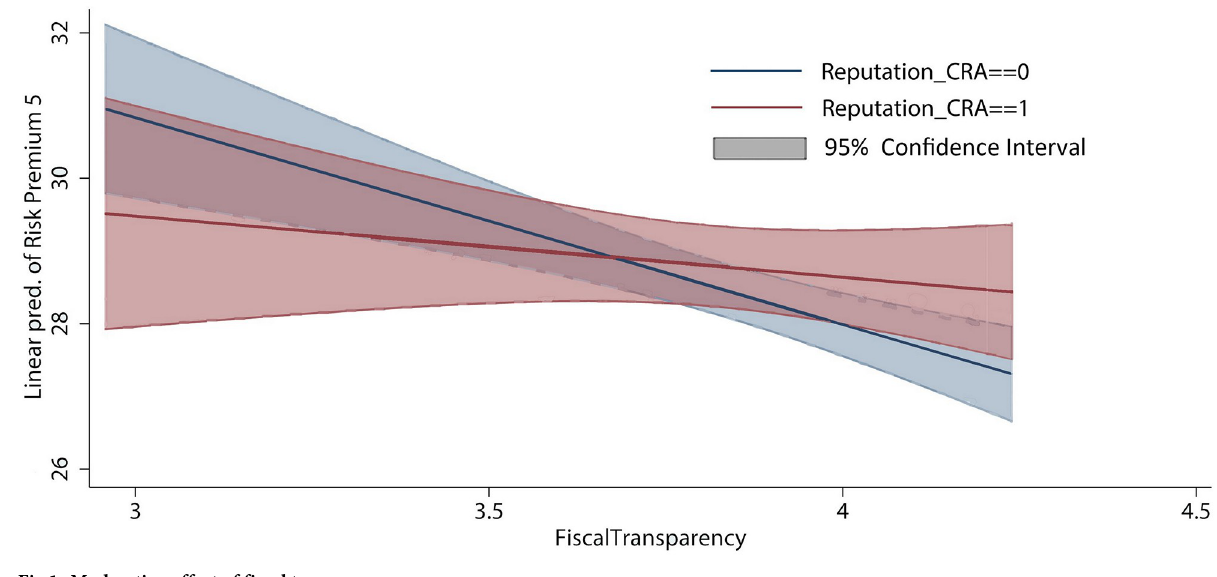
Fig 1. Moderating effect of fiscal